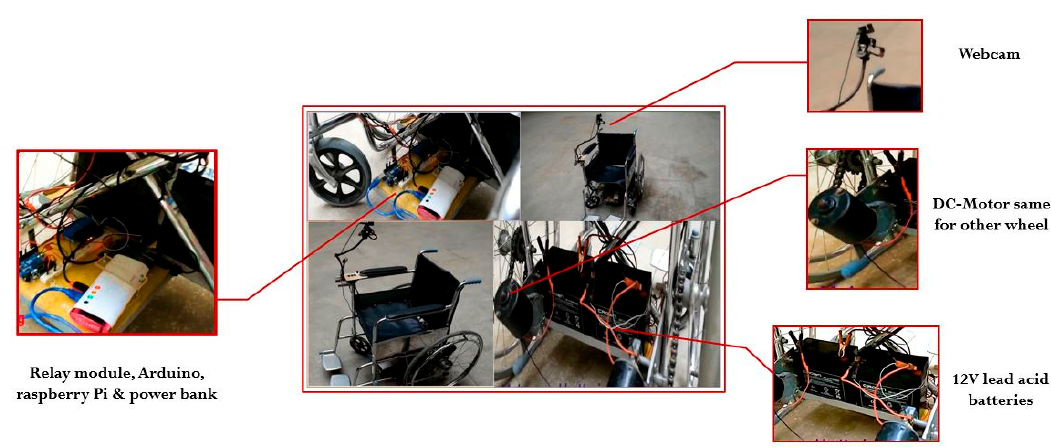
Figure 9. Complete mechanical assembly of wheelchair.